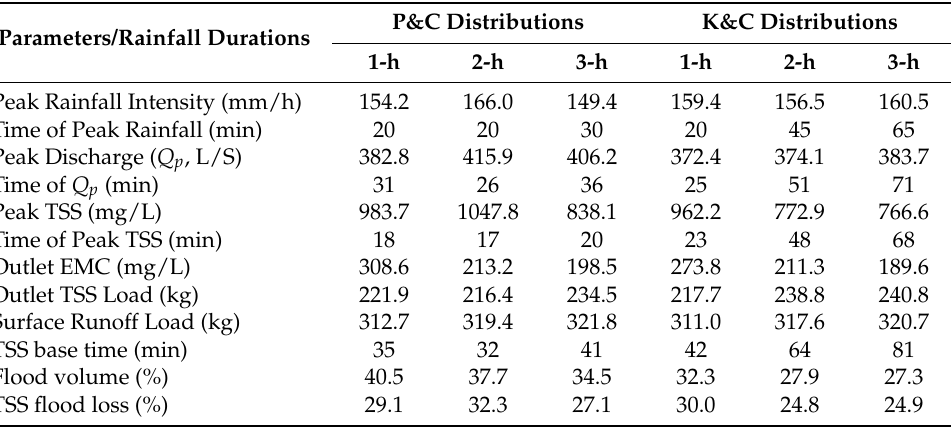
Table 7. Summary of simulated TSS characteristics for the three-year P&C distribtuion of design rainfall with three different rainfall